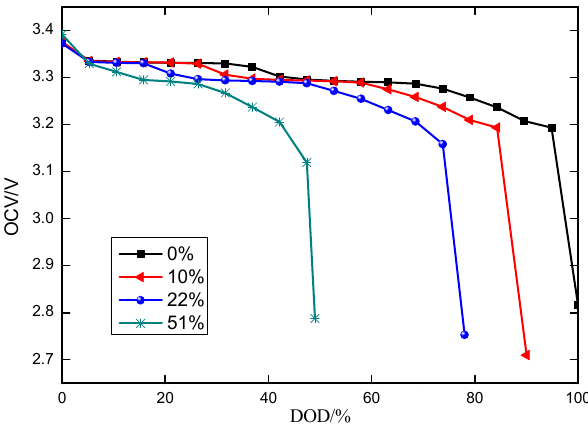
Figure 4. Relationship between OCV and DOD at different aging states.